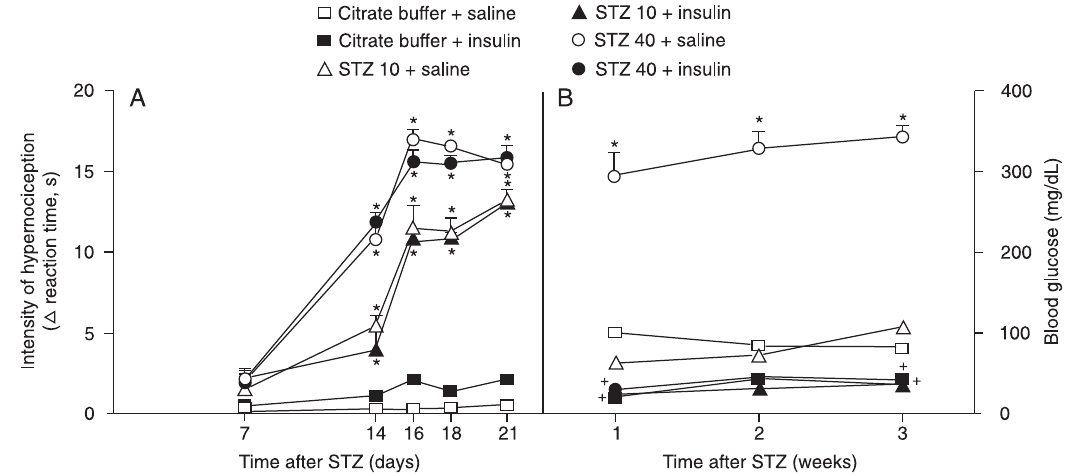
Figure 3. Mechanical hypernociception induced by streptozotocin (STZ) was not prevented by daily insulin treatment. Panel A, Mechanical hypernociception was evaluated on the days indicated after iv administration of vehicle (control group; citrate buffer, 10 mM, pH 4.5, equivalent volume) or STZ (10 or 40 mg/kg). Insulin or saline (equivalent volume) was administered subcutaneously twice (2 IU in the morning between 8:00 and 9:00 am, and 2 IU in the afternoon between 5:00 and 6:00 pm). Panel B, Glycemia was determined in the morning during the 1st, 2nd or 3rd week after citrate buffer or STZ treatment (10 or 40 mg/kg). Data are reported as means ± SEM for groups of 6 rats. *P < 0.05 compared to citrate-buffer saline and daily saline-treated rats; + P < 0.05 compared to daily saline-treated rats (ANOVA followed by the Bonferroni t-test).